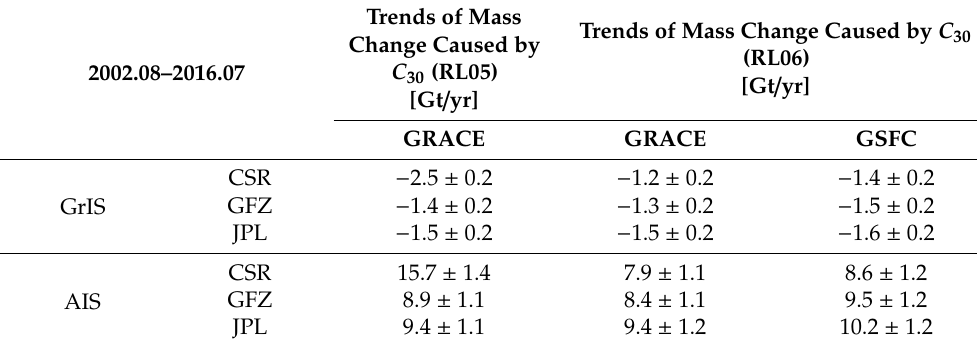
Table 5. The trend of mass variations caused by C 30 from GRACE RL05, RL06, and GSFC over the GrIS and the AIS during the period from August 2002 to July 2016.